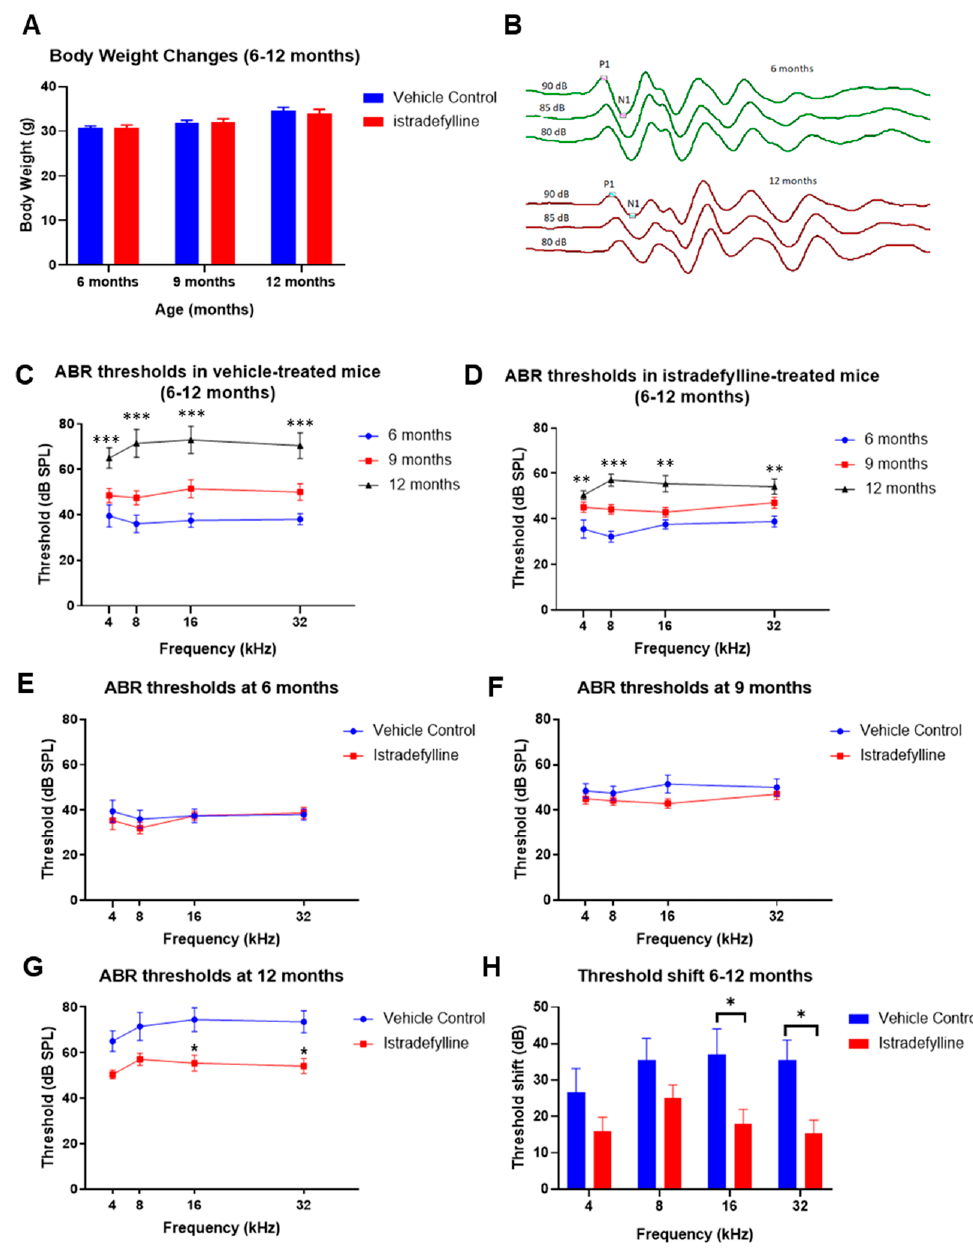
Figure 1. ( A ) Body weight changes in C57BL/6J mice from 6 to 12 months of age; ( B ) representative traces of ABR wave I at 6 months (green) and 12 months (red) recorded at 16 kHz at suprathreshold intensities. The peak (P1) and trough (N1) of ABR wave I are shown; ( C ) age-related increase in ABR thresholds for tone pips (4–32 kHz) in control vehicle-treated and ( D ) istradefylline-treated mice; ( E ) comparison of ABR thresholds at 6 months; ( F ) 9 months; ( G ) 12 months; ( H ) ABR threshold shifts in istradefylline- and control vehicle-treated mice calculated as the difference between ABR thresholds at 12 months and baseline ABR thresholds at 6 months. Data are expressed as means ± SEM. Vehicle control, n = 13; Istradefylline, n = 12. * p < 0.05; ** p < 0.01; *** p < 0.001. Two-way ANOVA followed by Holm–Sidak post hoc